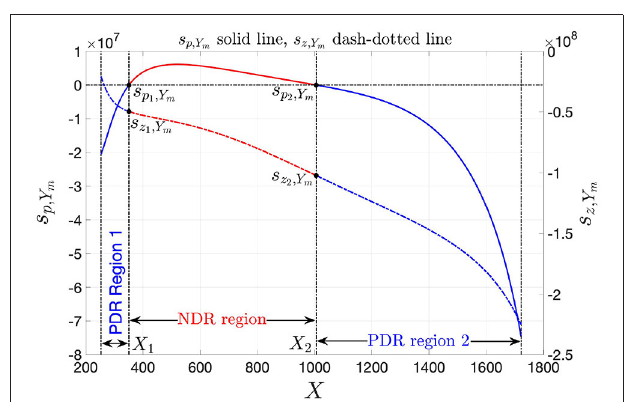
FIGURE 12 | Pole-zero diagram for the local admittance of the voltage-controlled NbO threshold switch from NaMLab GgmbH. While the zero is negative throughout the state operating domain X [ X a , X b ] [253, 1,722] from Figure 2 , the pole is negative (positive) in ∈ = either of the two PDR regions X [ X a , X 1 ) [253,351) and ∈ = X ( X 2 , X b ] (1,006,1,722] [throughout the NDR region ∈ = X ( X 1 , X 2 ) (351,1,006)] of the threshold switch DC characteristic. Here ∈ = s p ), respectively, are the values of the pole (zero) ( s z ) and s p ( s z 2 , Y m 2 , Y m 1 , Y m 1 , Y m of Y m ( s ) at the lower X 1 and upper X 2 bounds of the NDR state bias